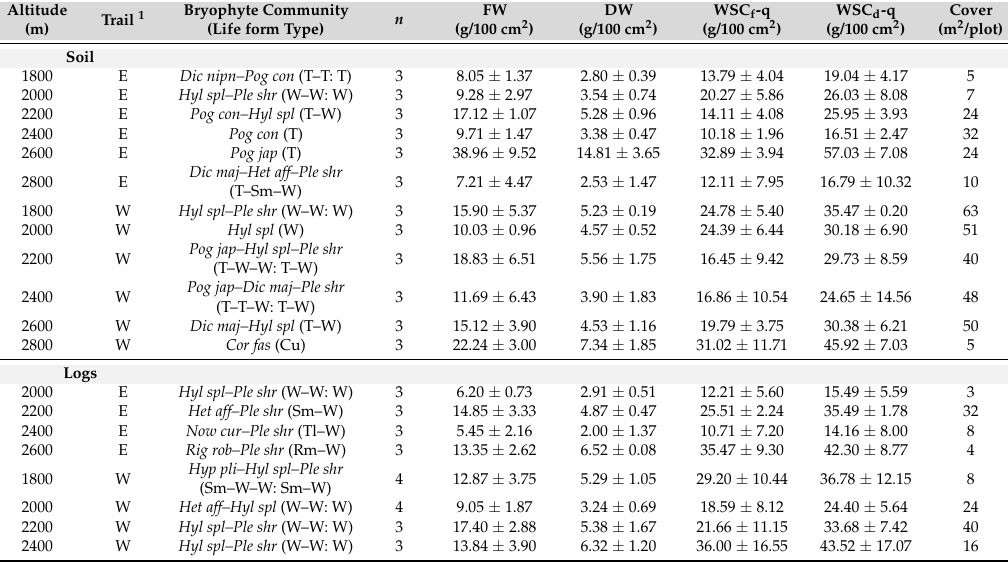
Table 1. Water storage capacity of dominant bryophyte communities at the quadrat scale (100 cm 2 ), and their total cover on each substrate within the study plots. Altitude